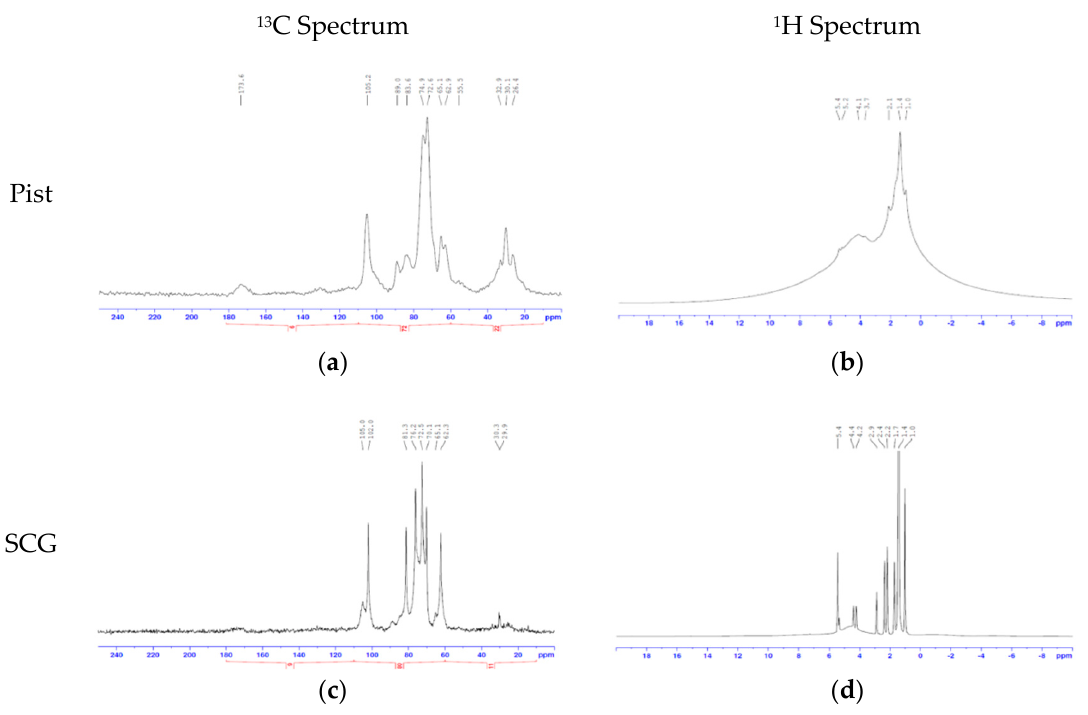
Figure 8. Fourier-transform infrared spectroscopy (FT-IR) spectra of the CEF samples. 13 C Spectrum